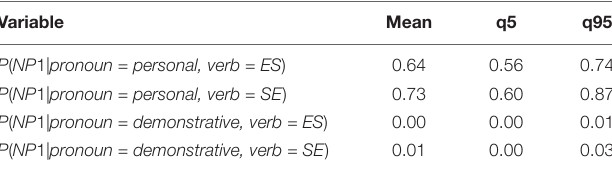
TABLE 15 | Value of P ( NP 1) across verb type and pronoun type for the Mirror model, Experiment 2.